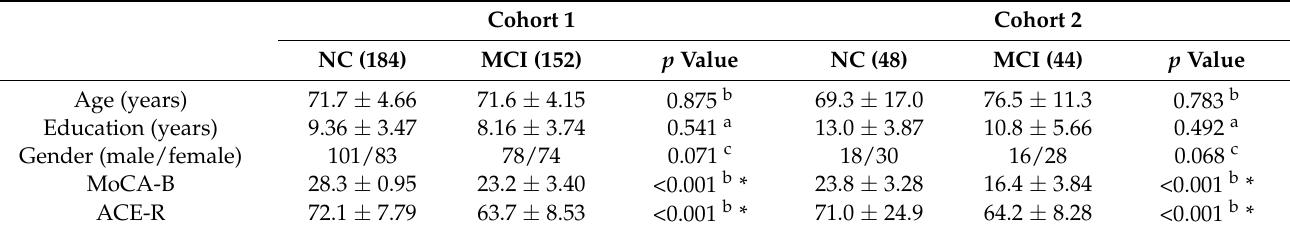
Table 1. Demographic and clinical characteristics of subjects.